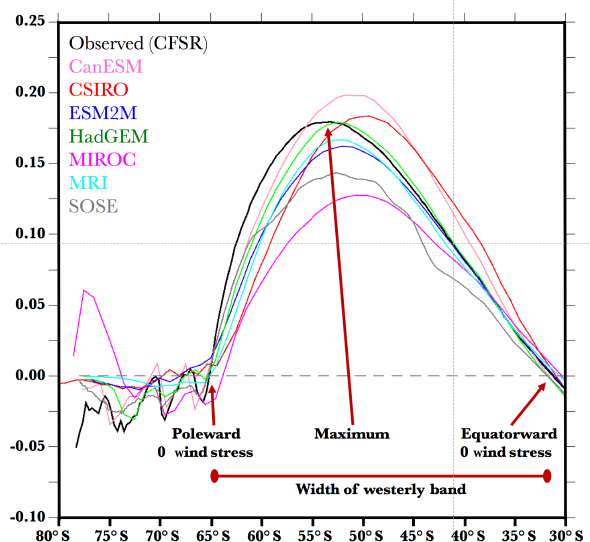
Figure 27. The zonal and annual means of the zonal wind stress (Nm − 2 ) for the reanalysis, six of the CMIP5 simulations, and the B-SOSE (Biogeochemical - Southern Ocean State Estimate) – note that each of the model simulations (colours) and B-SOSE (grey) have the peak wind stress equatorward of the observations (black). Also shown are the latitudes of the observed “poleward zero wind stress” and the “equatorward zero wind stress” which delineate the “width of the westerly band” that is highly correlated with total heat uptake by the Southern Ocean. Enhanced from figure produced by recipe_russell18jgr.yml see Sect. 3.3.2. For further discussion of this figure; see the original in Russell et al. (2018).